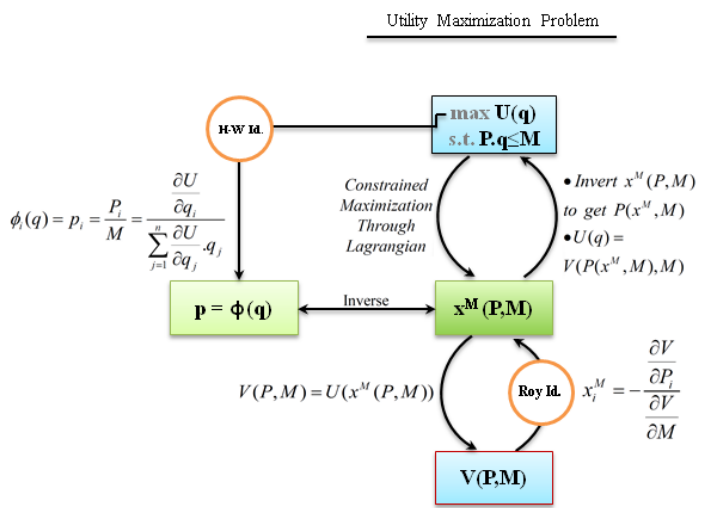
Figure 1. Different components of the Wheel of Duality in the utility maximization problem in the consumer theory. Adopted from Moosavian (2016) [10].